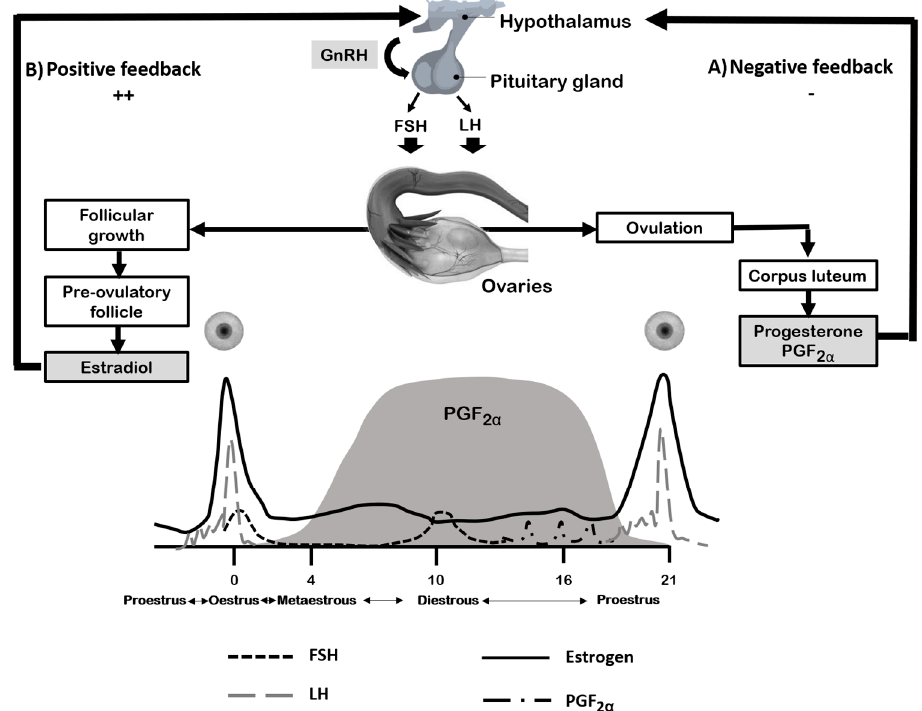
Figure 1. Simplified scheme of the hormonal interactions of the hypothalamus-pituitary-ovarian axis during the estrous cycle. ( A ) Negative feedback: Decreased LH concentration characteristic of the late follicular phase. The initial e ff ects of ovarian steroids eliminate the responsiveness of the pituitary to the action of GnRH, since the secretion of these by the hypothalamus is continuous at this stage; ( B ) positive feedback: Continuation of the previous period, here is a significant increase (about 90%) in the concentration of LH. The e ff ect produced result from the combined action of high levels of estrogen and progesterone (of ovarian origin) on the hypothalamus and of the latter (through hormonal release factors) on the pituitary. This phenomenon constitutes the endocrine event that characterizes the preovulatory period.